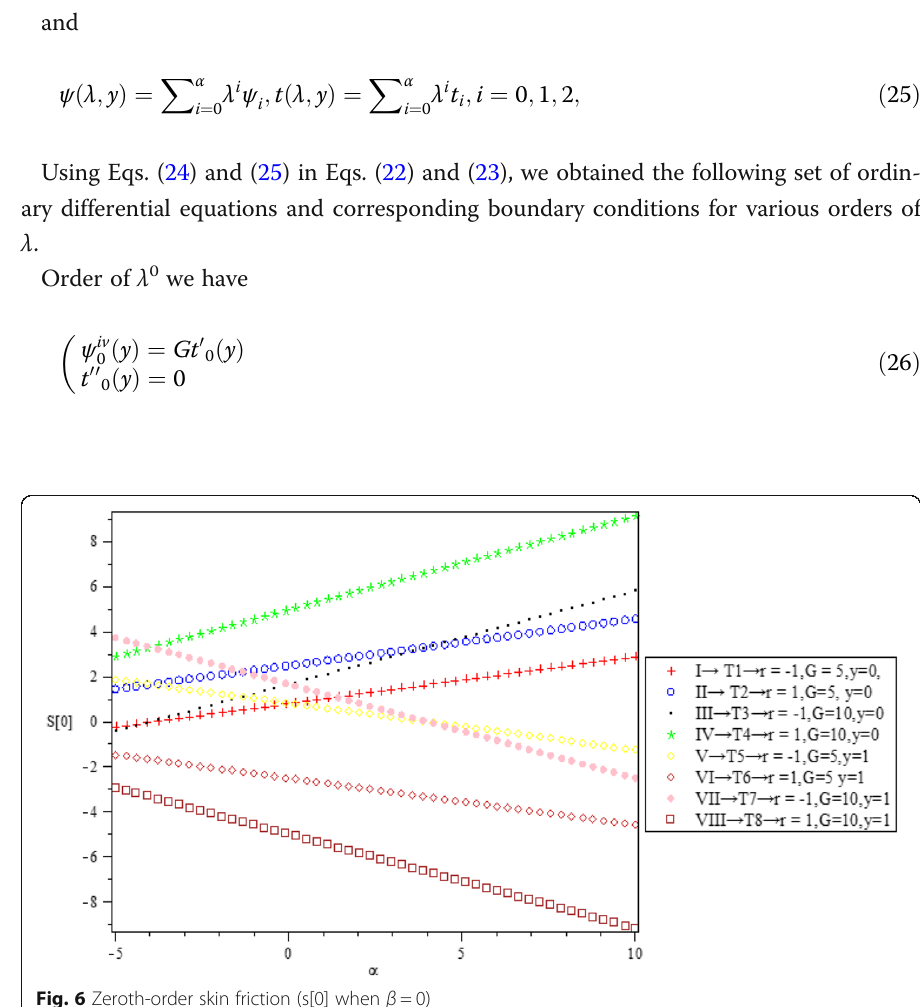
Fig. 6 Zeroth-order skin friction (s[0] when β =